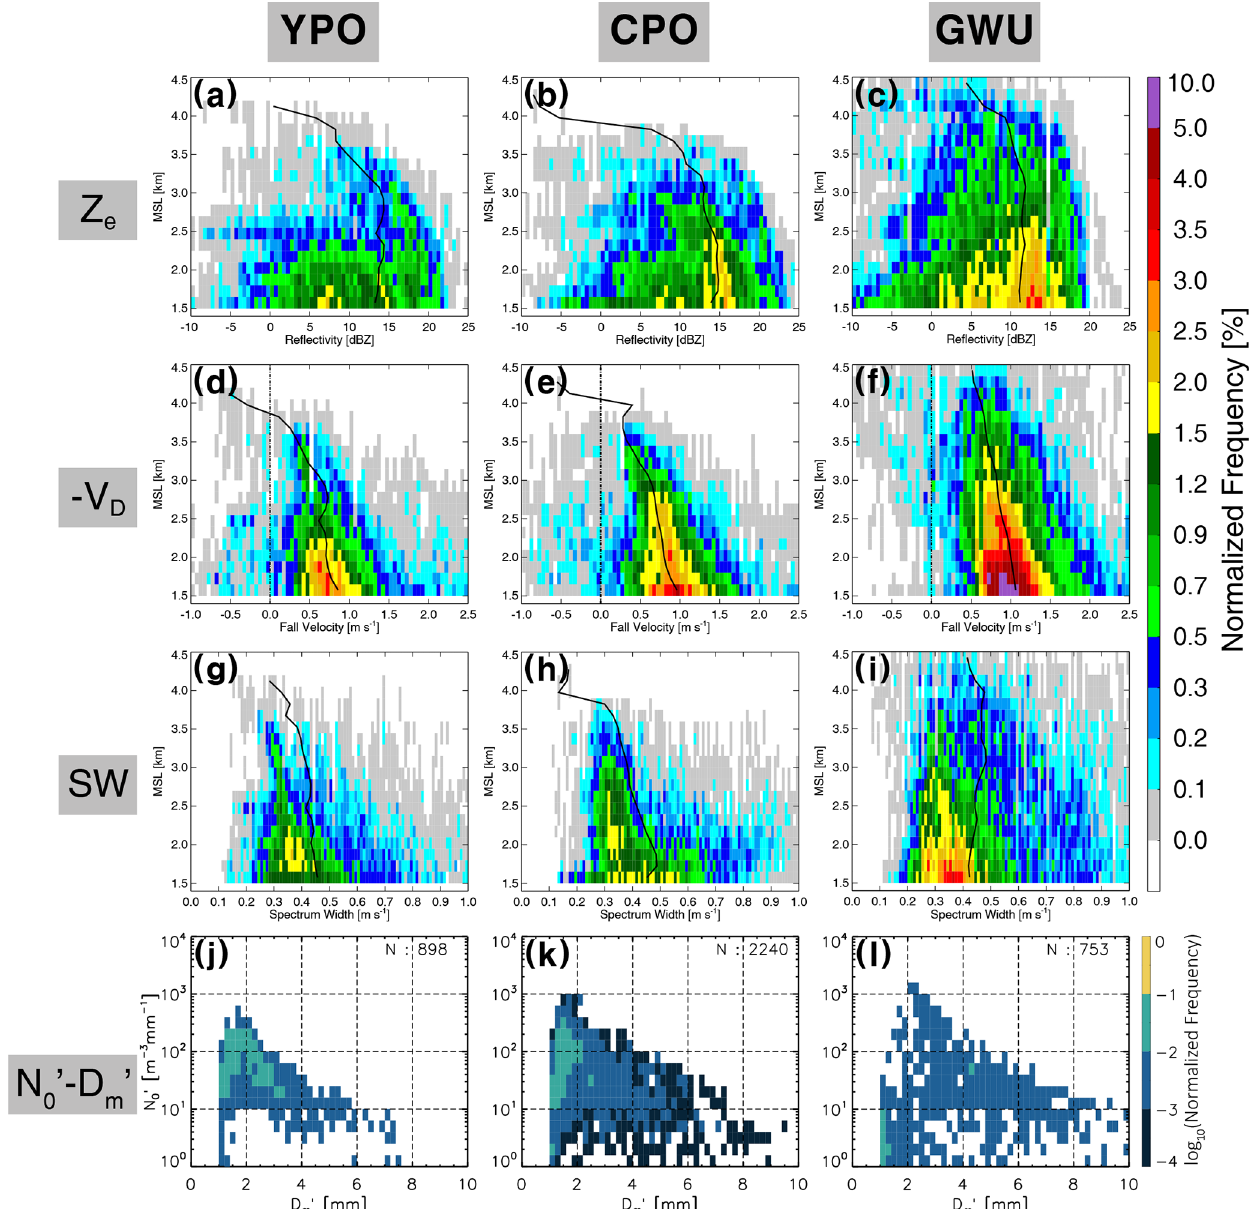
Figure 7. CFADs of radar reflectivity (dBZ; a–c ), negative of Doppler radial velocity (ms − 1 ; d–f ), and spectral width (ms − 1 ; g–i ) from MRR (a–i) and normalized frequency of N (cid:48) – D (cid:48) m (j–l) at YPO, CPO, and GWU sites for the air–sea interaction events during two winter 0 seasons. The number of snow-observed minutes at the ground by PARSIVEL is shown in the upper right corner of the diagram in the fourth row. The mean liquid-equivalent precipitation rate from the Z e –SR relationship at 24.23GHz (Souverijns et al., 2017) at 1.5km height is 1.16, 1.33, and 0.75mmh − 1 for YPO, CPO, and GWU,